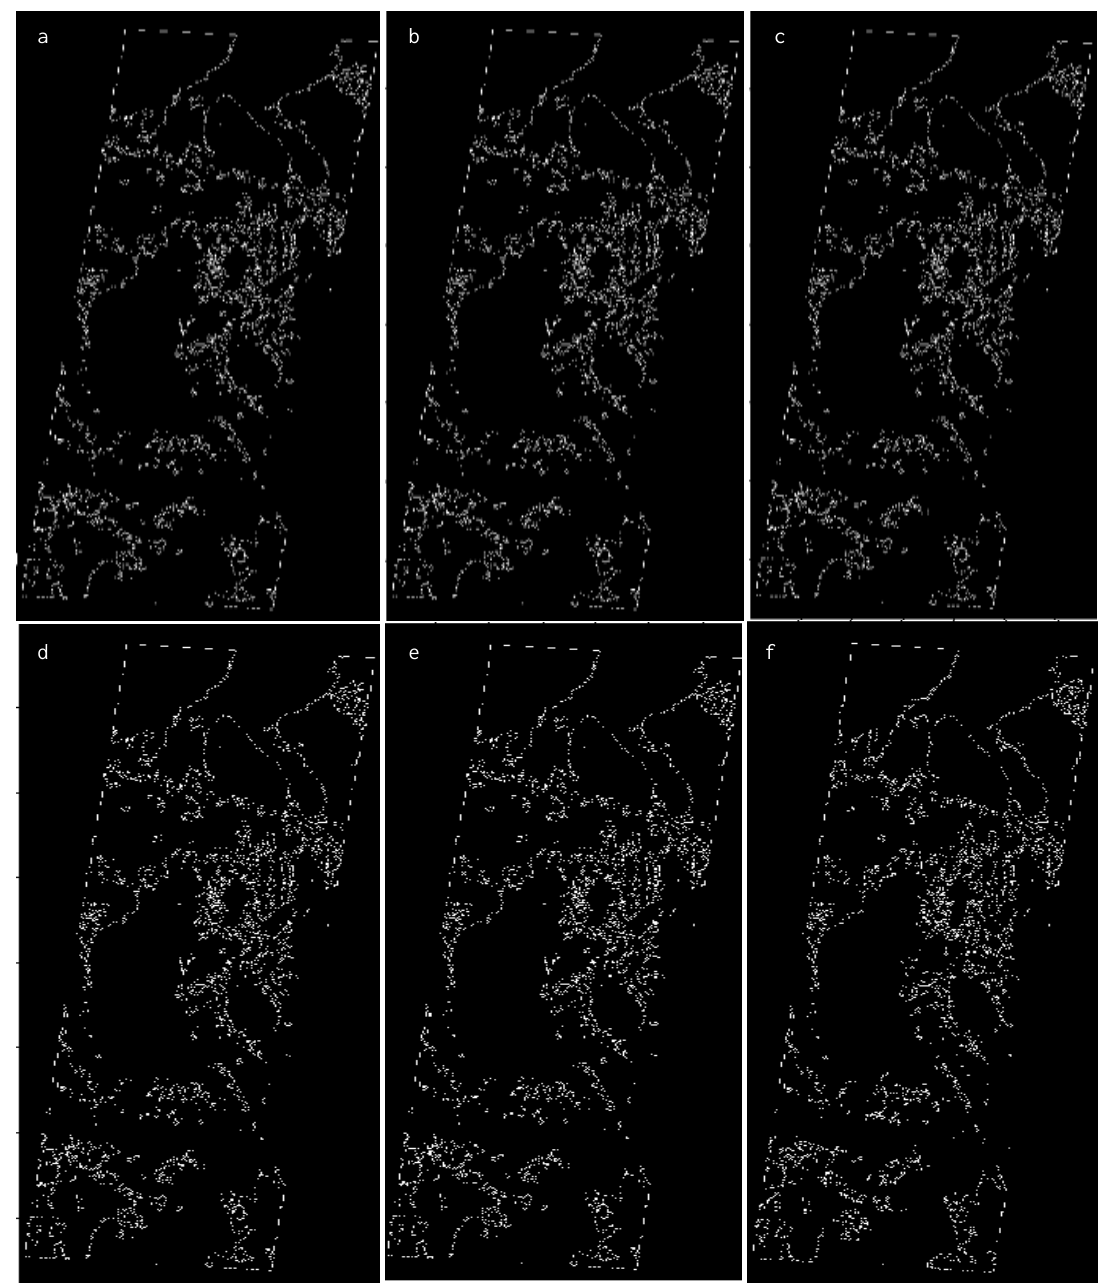
Figure 3. Edges for test case 1 by proposed algorithm